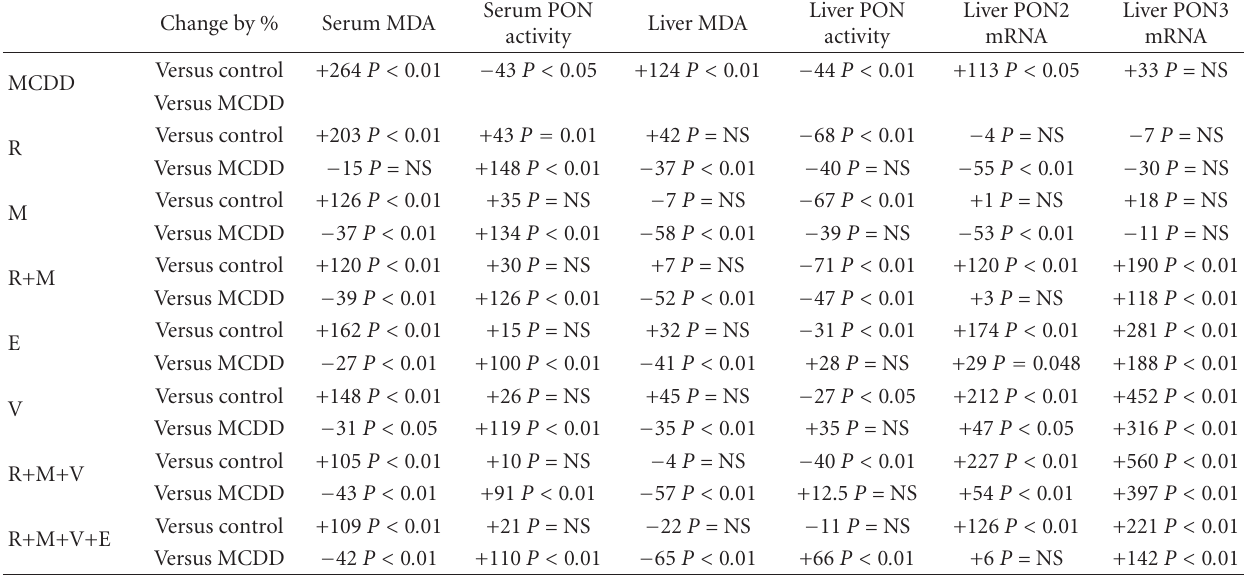
00.511.522.5 (a) Figure 1: Malondialdehyde (MDA) in sera (a) and livers (b) in rat experimental fatty liver model. Fatty liver in Sprague-Dawley rats was induced by methionine-choline-deficient diet (MCDD) for 9 weeks. Rats were treated for other 6 weeks with rosiglitazone (R); metformin (M); rosiglitazone + metformin combination (R+M); ezetimibe (E); valsartan (V); rosiglitazone + metformin + valsartan in combination (R+M+V), or rosiglitazone + metformin + valsartan + ezetimibe (R+M+V+E). “ # ” indicates P < 0 . 05 versus control group (fed by standard rat chow). “ ∗ ” indicates P < 0 . 05 versus MCDD group. Table 1: Results of serum versus liver in rat experimental fatty liver model. Fatty liver in Sprague-Dawley rats was induced by methionine- choline-deficient diet (MCDD) for 9 weeks. Rats were treated for other 6 weeks with rosiglitazone (R); metformin (M); rosiglitazone + metformin combination (R+M); ezetimibe (E); valsartan (V); rosiglitazone + metformin + valsartan in combination (R+M+V) or rosigli- tazone + metformin + valsartan + ezetimibe (R+M+V+E). Malondialdehyde (MDA), Paraoxonase (PON). +203 P < 0 .